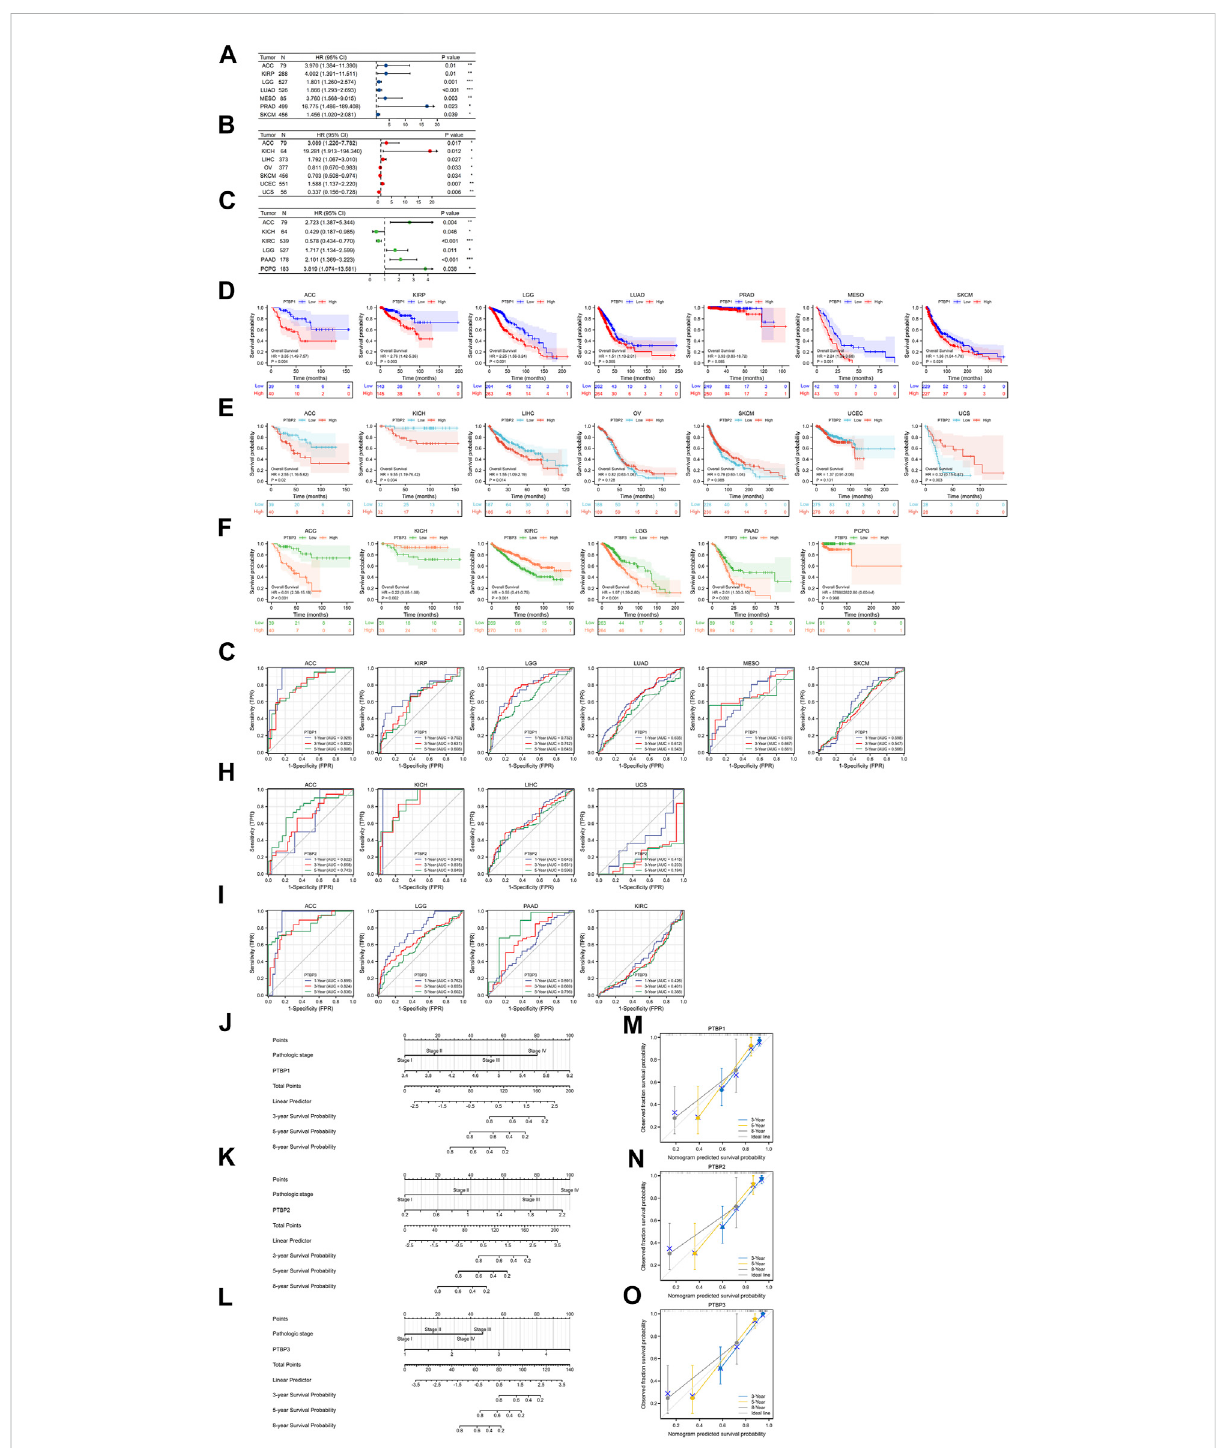
FIGURE 4 Evaluation of the prognostic value of PTBPs in pan-cancer. The multivariate Cox regression analysis results of (A) PTBP1 , (B) PTBP2 , and (C) PTBP3 were visualized and presented as forest plots (* p < 0.05; ** p < 0.01; *** p < 0.001). (D – F) OS-KM survival curves of PTBPs in multiple cancers. (G – I) Time-dependent ROC curves of PTBPs to evaluate the utility of PTBPs as prognostic markers in selected tumor types. (J – O) Prognostic nomograms of PTBP expression combined with pathological stage in ACC. (M – O) The calibration curves for